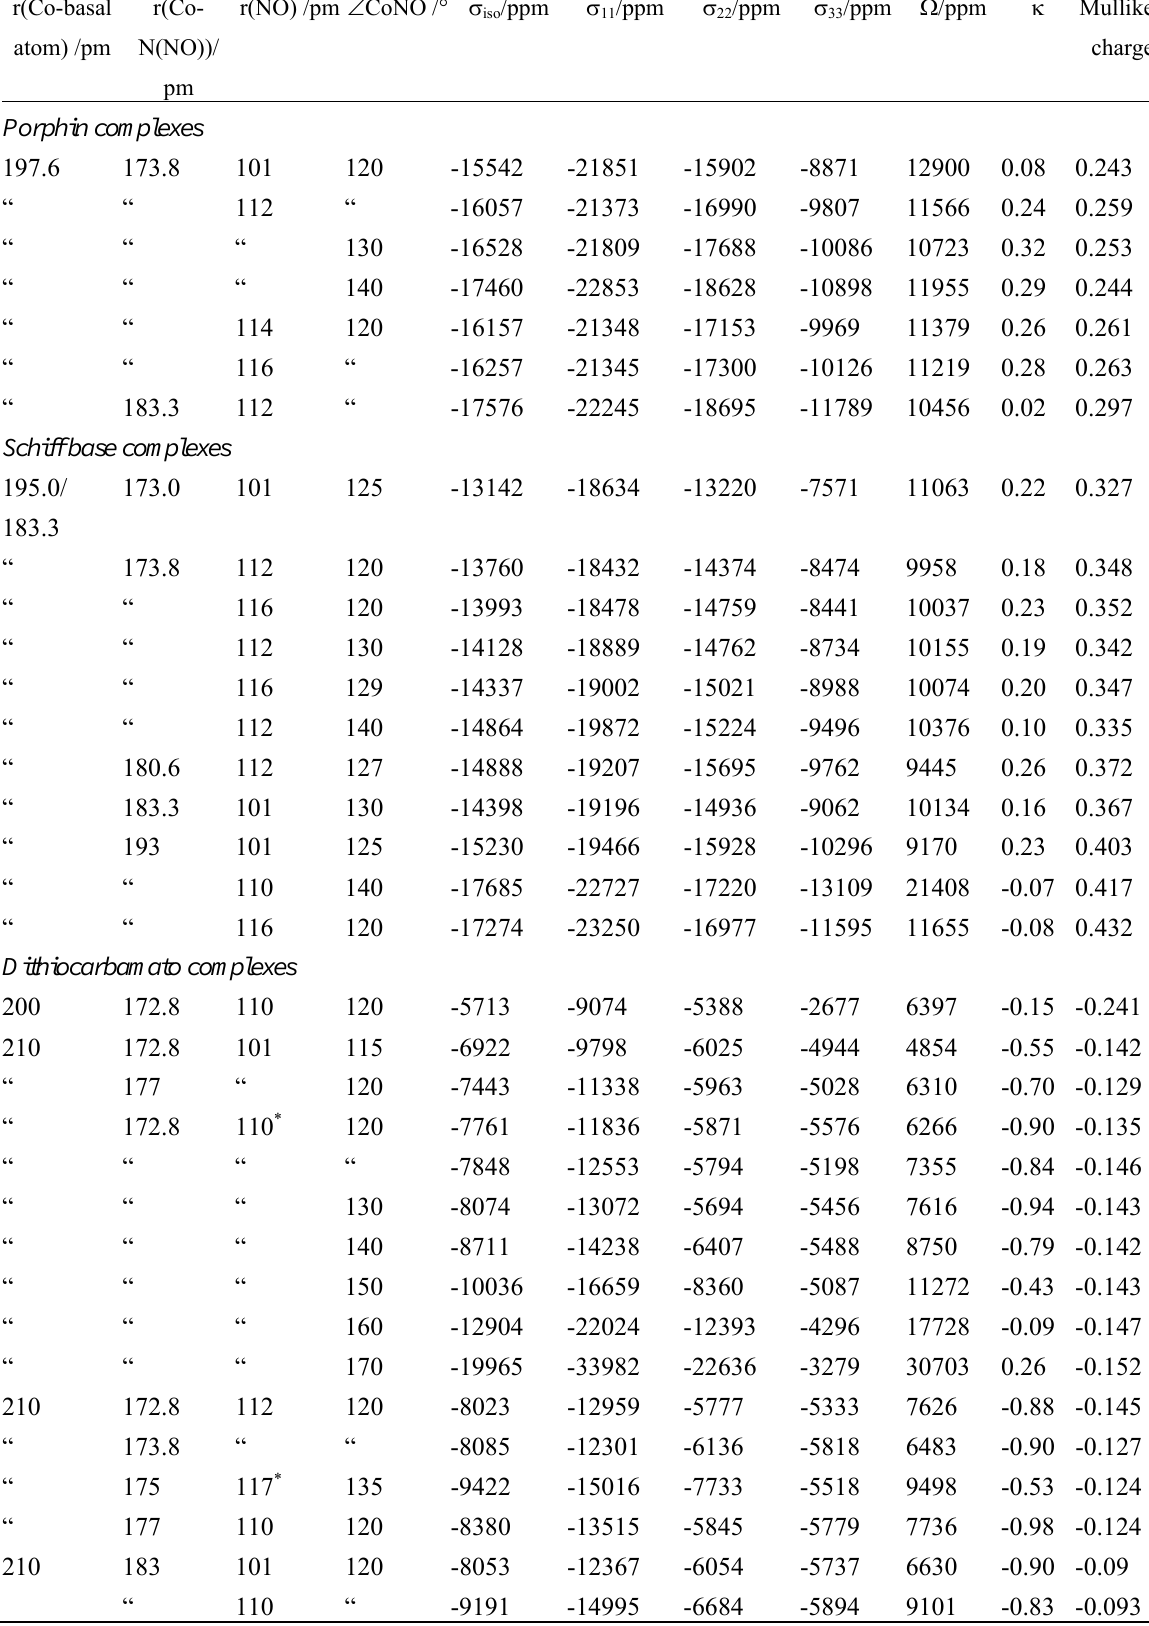
Table 1. Calculated Co shielding tensors for model square pyramidal nitrosyl complexes.